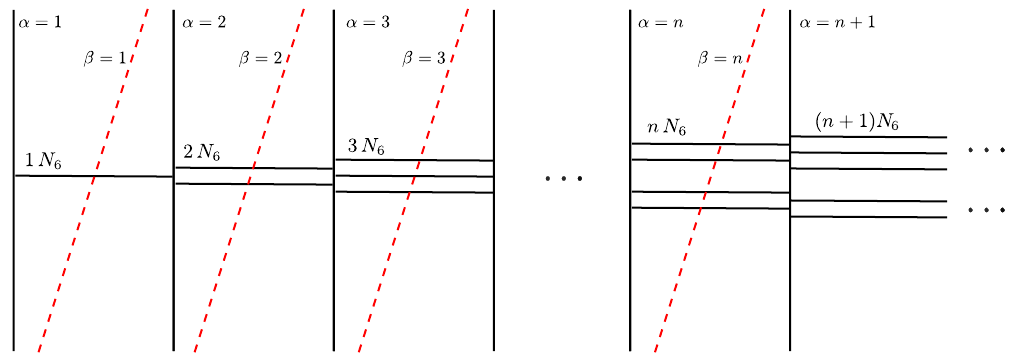
Figure 1 . Brane set-up consistent with the quantized charges of the non-Abelian T-dual solution, consisting on (cid:11) = 1 ; 2 ; : : : ; n +1 NS5-branes (vertical black lines), (cid:12) = 1 ; 2 ; : : : ; n NS5’-branes (tilted red dashed lines) and m N 6 D4-branes (horizontal lines), where m = 1 ; 2 ; : : : ; n + 1 changes by one each time a NS5-brane is